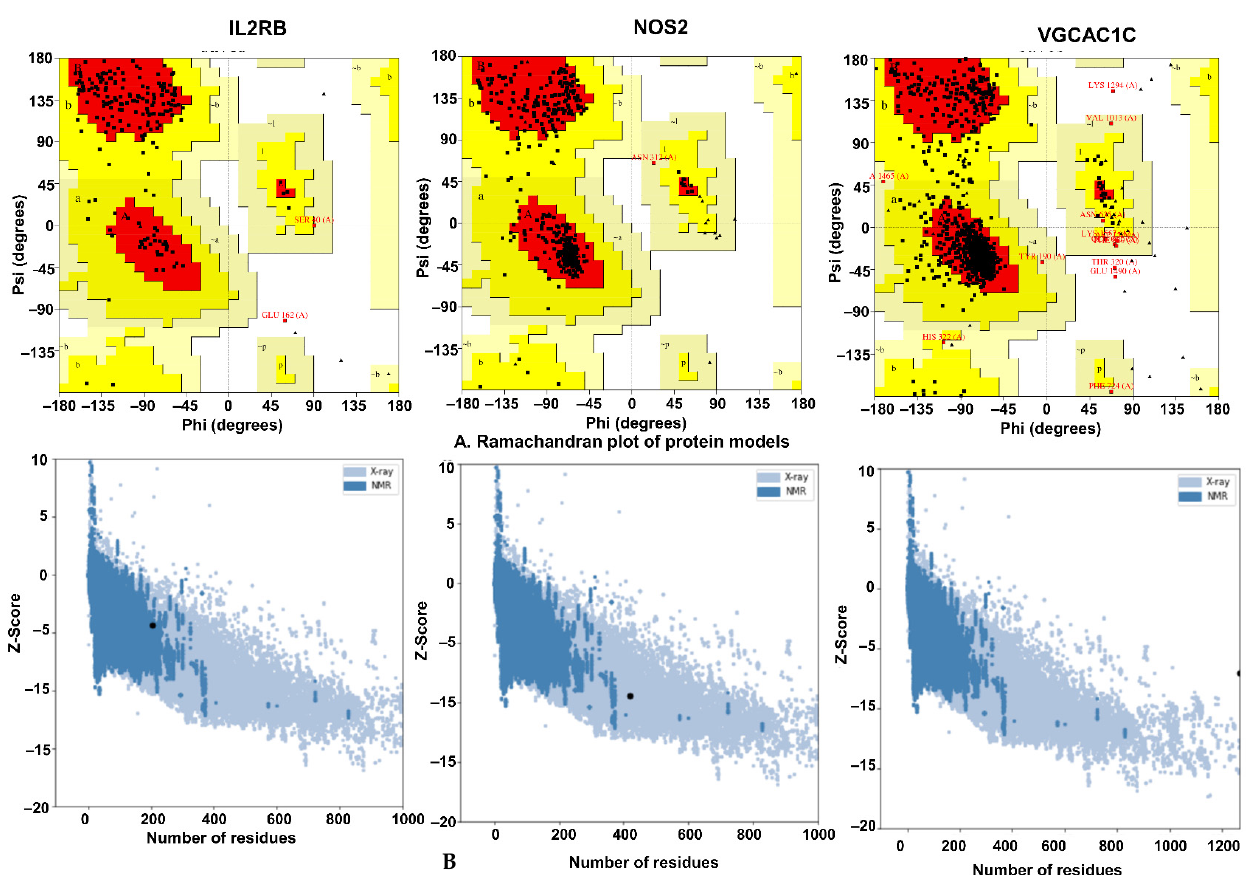
Figure 12. Validation of IL2RB, NOS2, and VGCAC1C models. ( A ) Ramachandran plot of proteins to identify the distribution of amino acid residues. ( B ) Z–score plot of protein models.